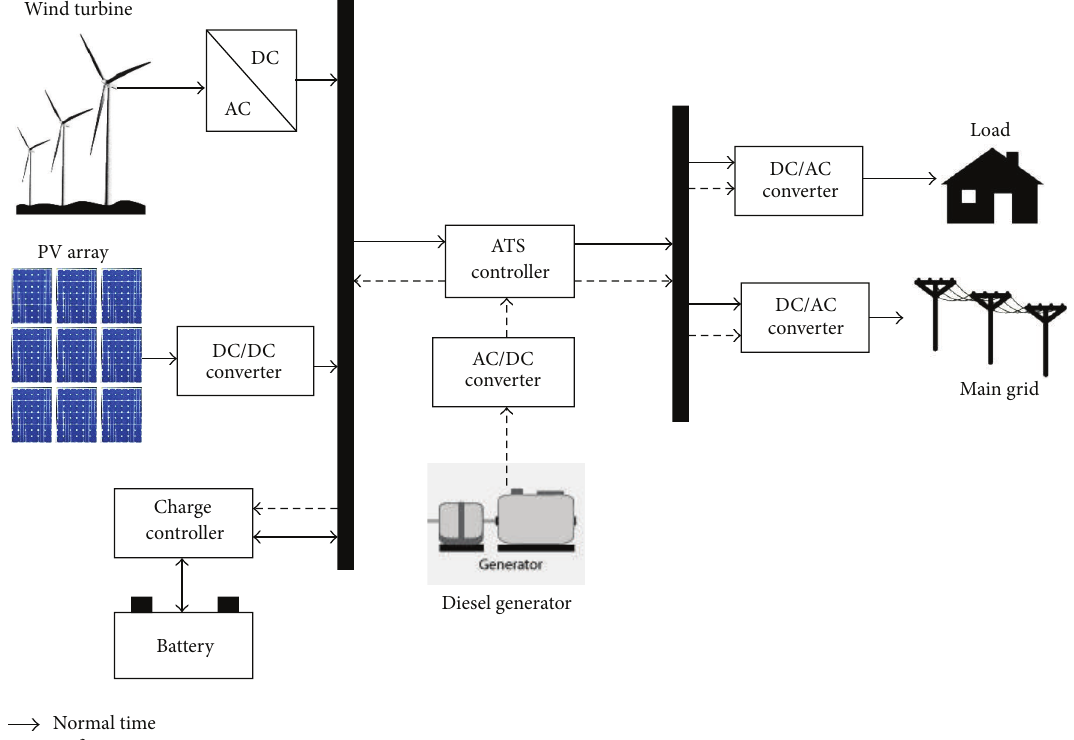
Figure 1: Building integrated hybrid PV/wind/diesel generating